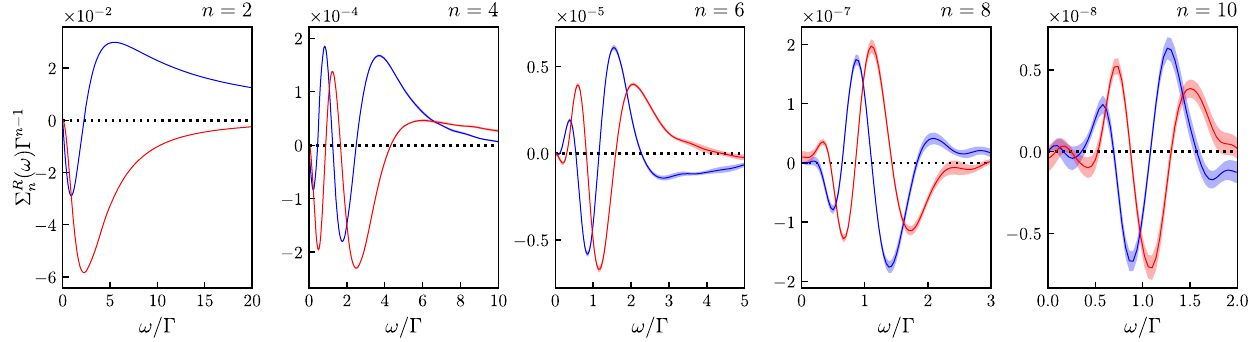
FIG. 2. First nonzero orders of the self-energy series Σ R ð U; ω Þ in powers of U for the equilibrium particle-hole symmetric Anderson model (real part in blue and imaginary part in red). This series is computed with a real-time diagrammatic quantum Monte Carlo algorithm detailed in a companion article [64]. The statistical error is shown as shaded areas. Because of particle-hole symmetry, odd orders are